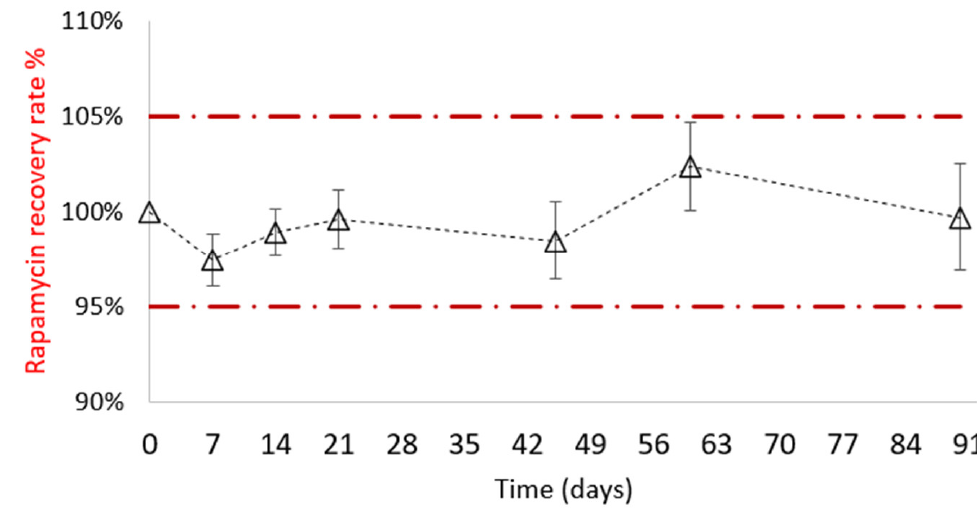
Figure 10. Rapamycin recovery rate % monitoring, calculated with respect to the initial time value ( n = 3).